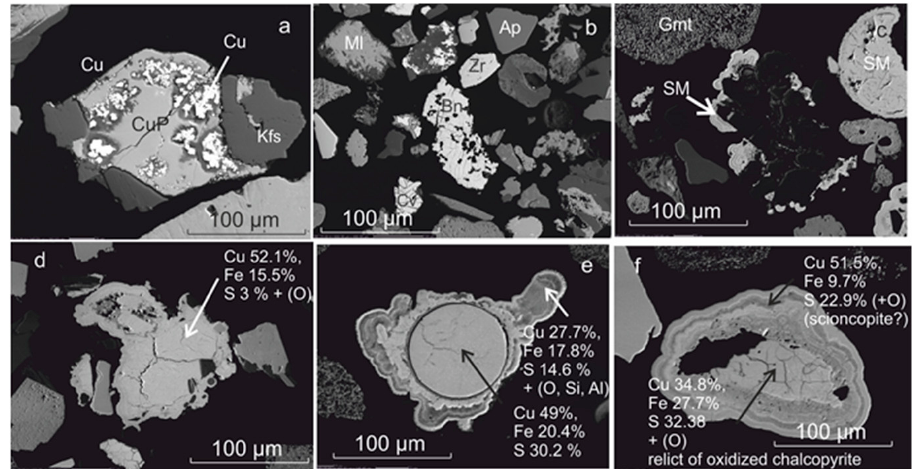
Figure 13. Components of contaminated sediments of the Kafue River and its tributaries in the Zambian Copperbelt districts. ( a ) Cu-phosphate (CuP—pseudomalachite?) with the accumulation of native copper (Cu) and grain of microcline (Kfs), the Changa River. ( b ) Bornite (Bn), malachite or azurite (? Mi), apatite (Ap), covellite (Cv), and zircon (Zr), the Kafue River, Chingola area. ( c ) Intermediate solid solution of Cu, Fe, and S (SM), and magnetite-rich slag glass (Gmt) in sediments of the Uchi River (tributary of the Kafue River in Kitwe). ( d – f ) Chemical composition of different types of intermediate solid solution particles (Cu–Fe–S, Cu–Fe–Co–S, and Cu–Fe–S–O) in sediments of the Uchi River, tributary to Kafue, Kitwe area. SEM, backscattered electrons. Modified after Sracek et al. [75].